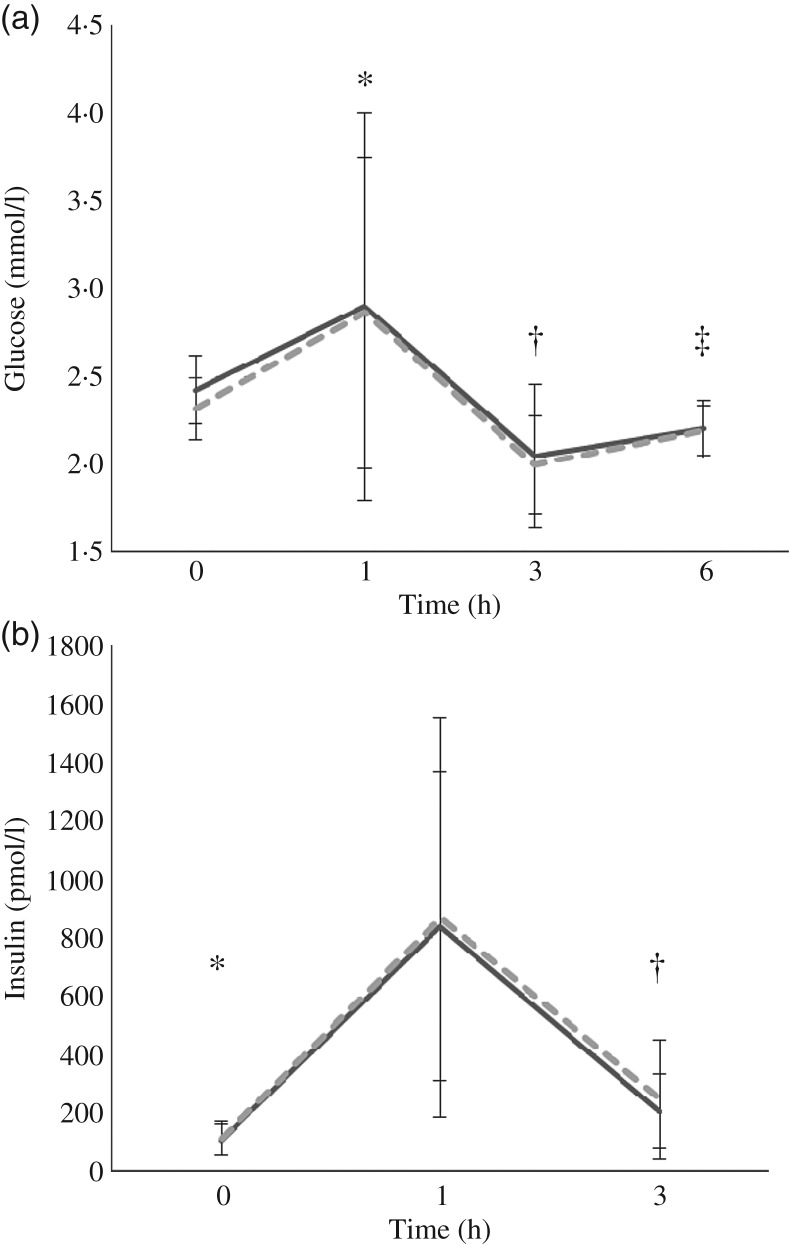
Postprandial response of glucose (a) and insulin (b) before and after high-fat
mixed meal rich in SFA from either vegan alternative cheese (---) or Cheddar cheese
(––). Values are means, with standard deviations represented by vertical bars
(n 20). * Significant difference between 0 and 1 h
(P < 0·0005). † Significant difference between 1 and 3 h
(P < 0·0005). ‡ Significant difference between 3 and 6 h
(P = 0·01).